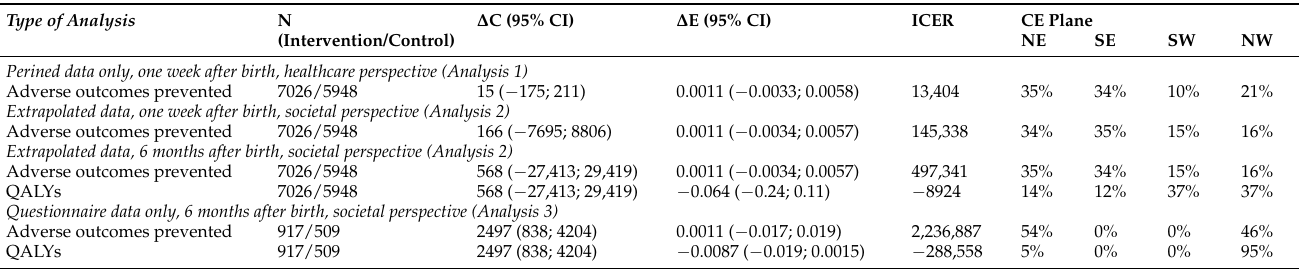
Table 3. Incremental cost-effectiveness outcomes of routine third trimester ultrasonography with usual care compared to usual care only.